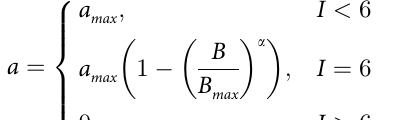
, utilized for structural biomass or converted into storage lipids at rates r CO2 , m